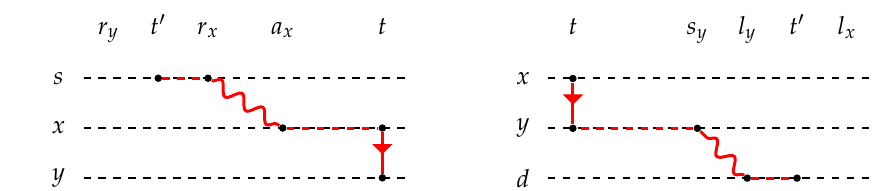
Figure 3. The update rule of the temporal breadth-first search algorithm for computing the closeness of a node s ( left ) and of its “backward” version for computing the contribution of a node d to the closeness of all the other nodes ( right